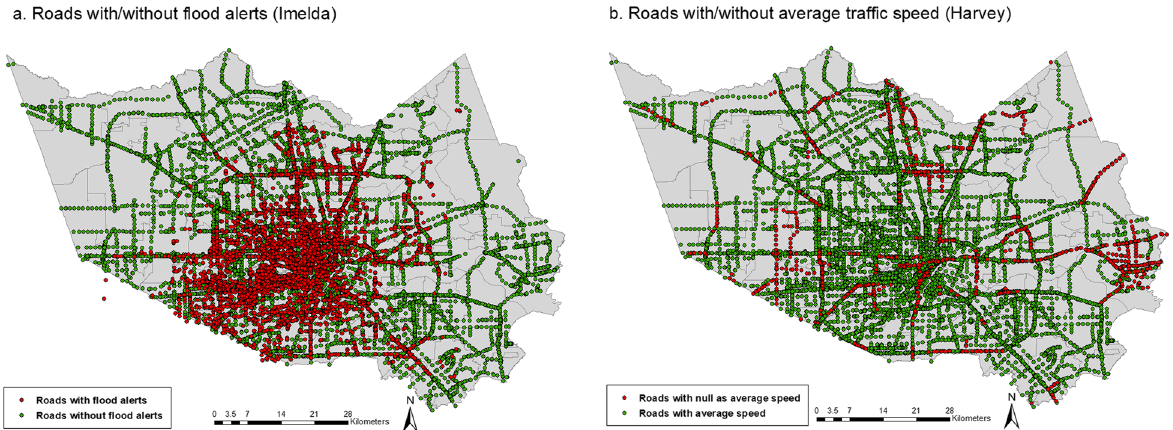
Fig. 3 Geographic distributions of flooded and non‑flooded roads from Waze reports for Tropical Storm Imelda ( 3a ) and from INRIX for Hurricane Harvey ( 3b ). Each point represents the location of a road